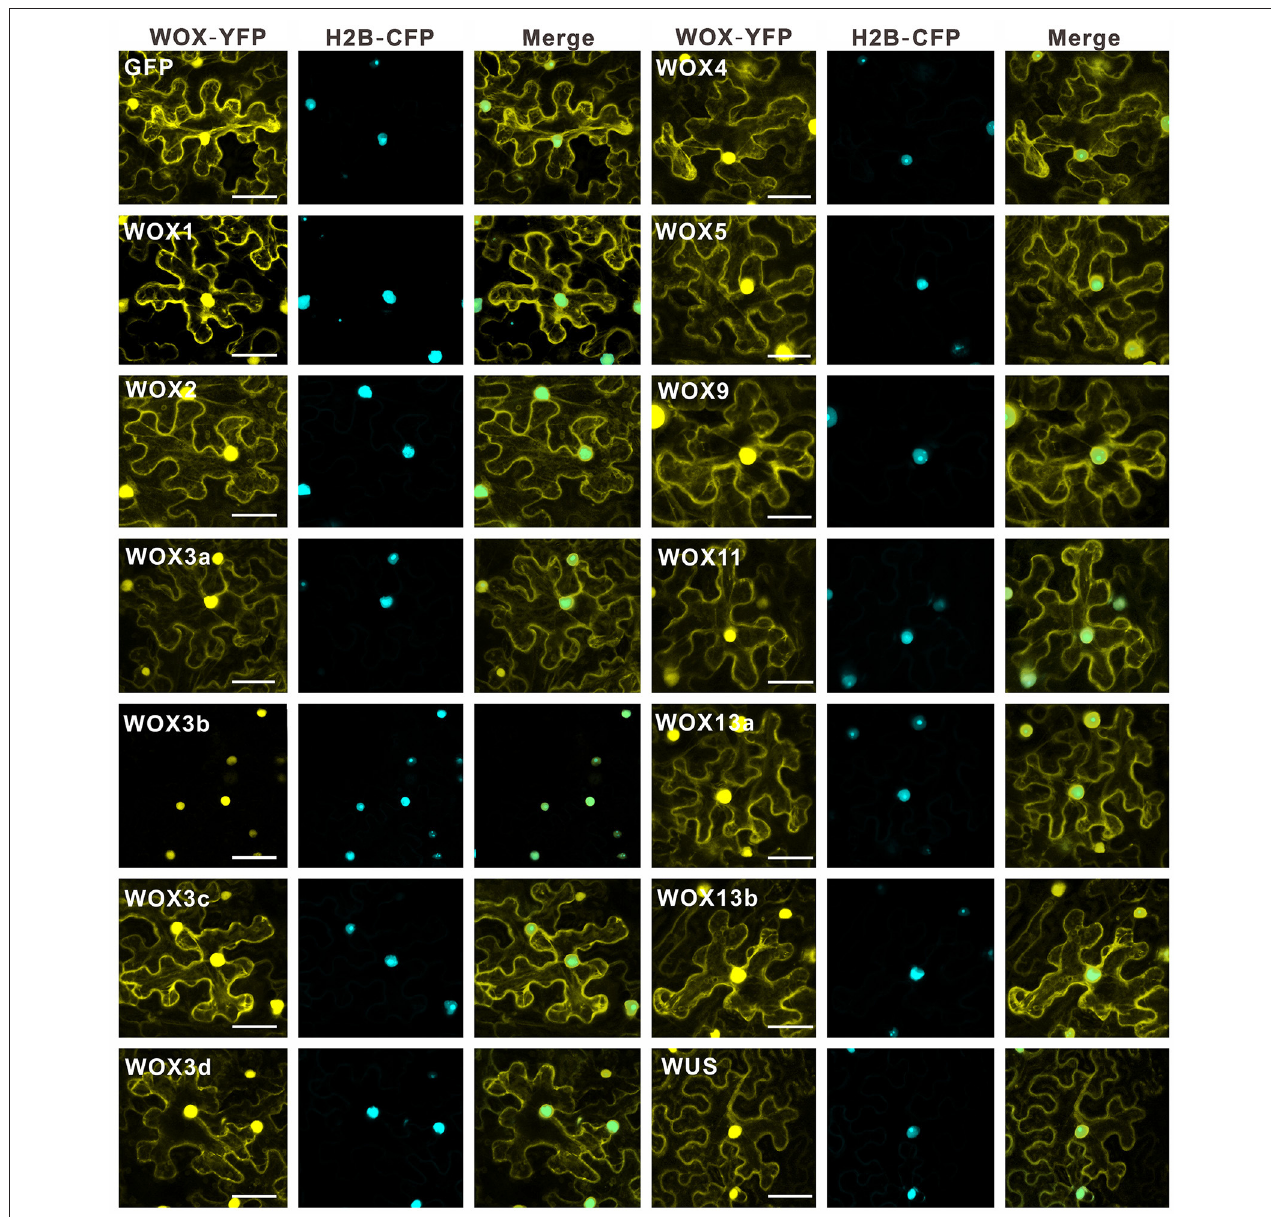
FIGURE 6 | Subcellular location analysis of WOX family proteins in N. benthamiana leaves. YFP alone was used as a control. Bar = 50 µ